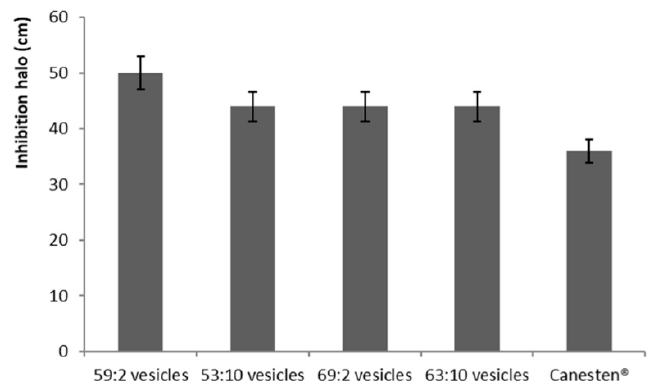
Figure 6. In vitro inhibition halo against C. albicans provided by the clotrimazole-containing, three-dimensionally-structured hybrid vesicles or Canesten ® cream. Data are reported as mean values ± standard deviation (error bars) of six values.